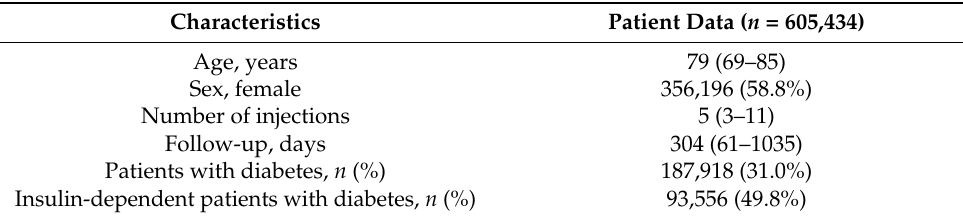
Table 1. Baseline demographics of patients with intravitreal injections of corticosteroids or anti-VEGF (vascular endothelial growth factor) agents from 2009 to